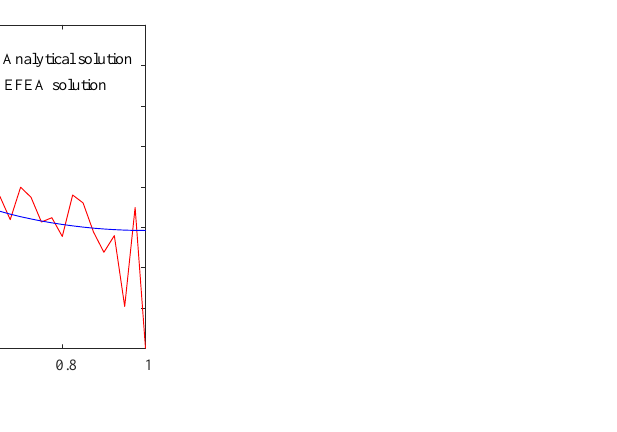
Figure 4. Energy density distribution for a plate with FFLD treatment ( f = 3 kHz, η 2 = 0.8, h 2 = 0.002 m). ( a ) EFEA solution. ( b ) Analytical solution. ( c ) Energy density distribution at x 0 = 0.5 m. Figure 7 shows the energy density distribution for various loss factors of the damping layer with the thickness h 2 = 0.002 m in the frequency f = 3 kHz. From Equation (36), under the same input power and excitation frequency, the overall energy density is inversely proportional to the loss factor. Therefore, the global variation in energy density increases with larger damping. Figure 8 shows the energy density distribution for various thicknesses of the damping layer with a loss factor η 2 = 0.8 in the frequency f = 3 kHz. Similar to the loss factor, the large damping layer thickness causes significant energy dissipation, which leads to a relatively dramatic attenuation in the energy density.